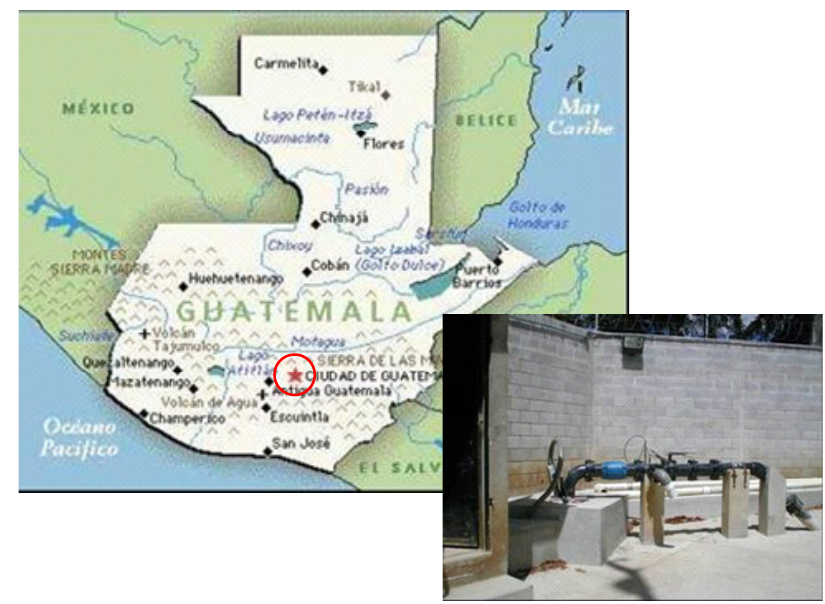
Figure 1. Study area: Naranjo County, Mixco, Guatemala (NCMG).